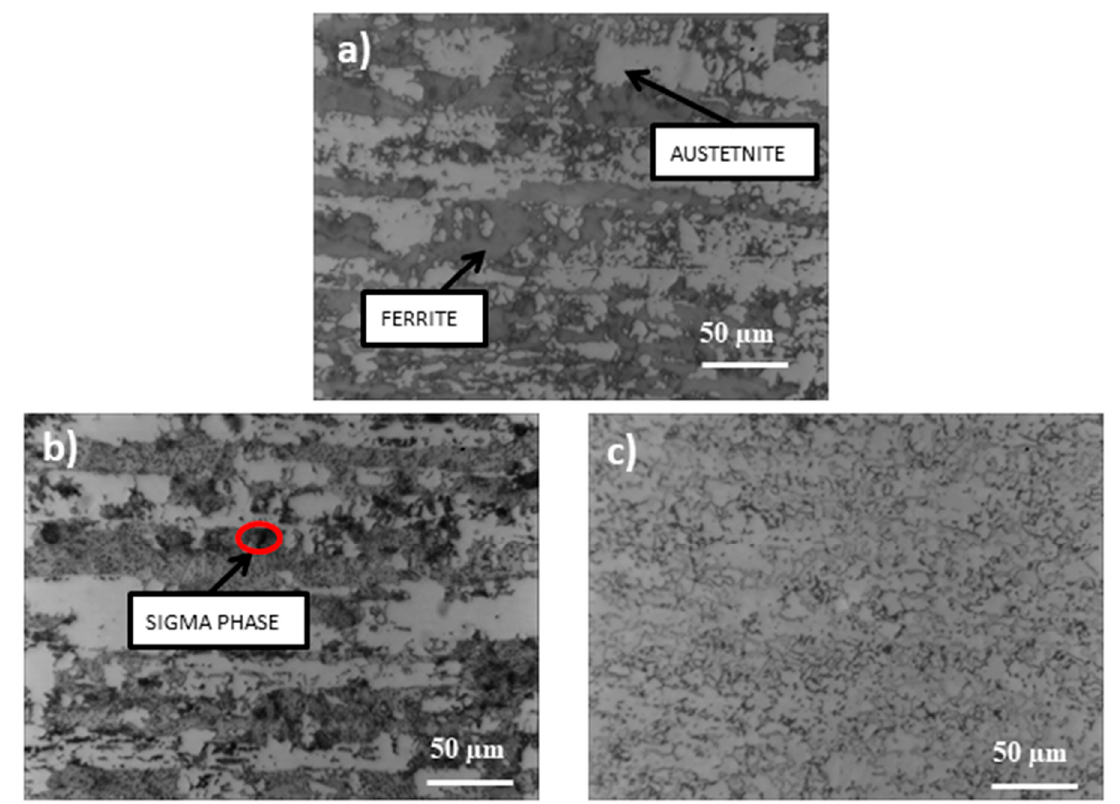
Figure 2. Microstructure of 1.4462 steel: ( a ) before annealing, ( b ) after annealing at 600 °C, ( c ) after annealing at 800 °C.